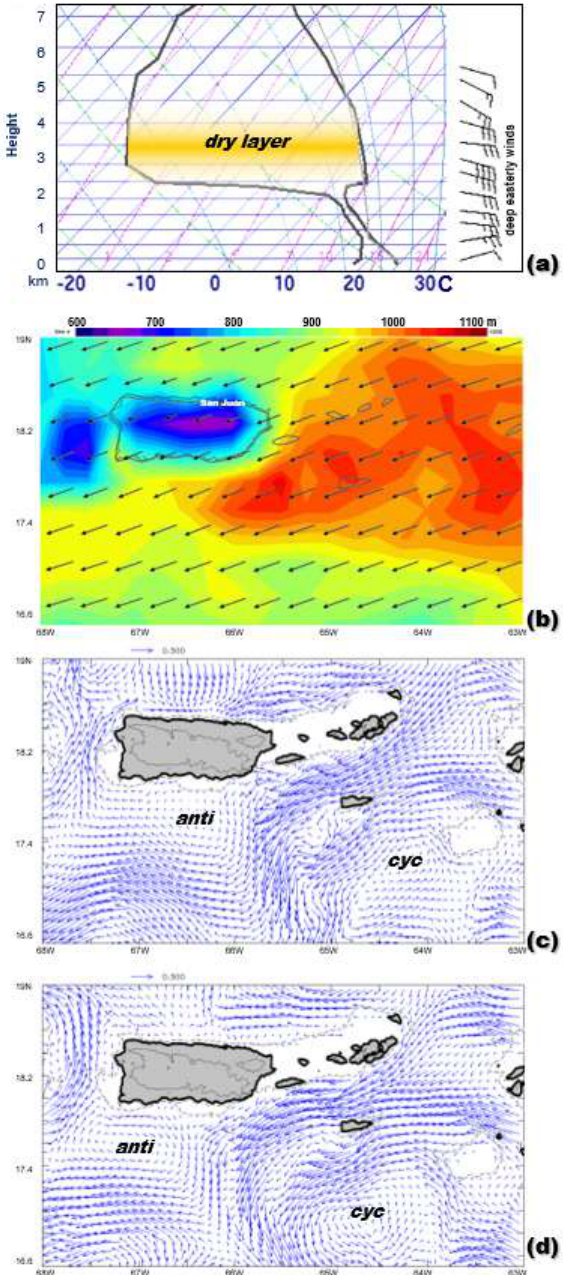
Figure 6. Anegada inflow case of 12 February 2001 (cf. Figure 4b): ( a ) San Juan radiosonde skew- Temperature plot and wind profile, ( b ) ERA5 atmospheric boundary layer height and surface wind vectors. ( c , d ) HYCOM 100 m currents on 12 February and 16 February, with rotating eddies labelled; contours refer to dashed bathymetry/solid